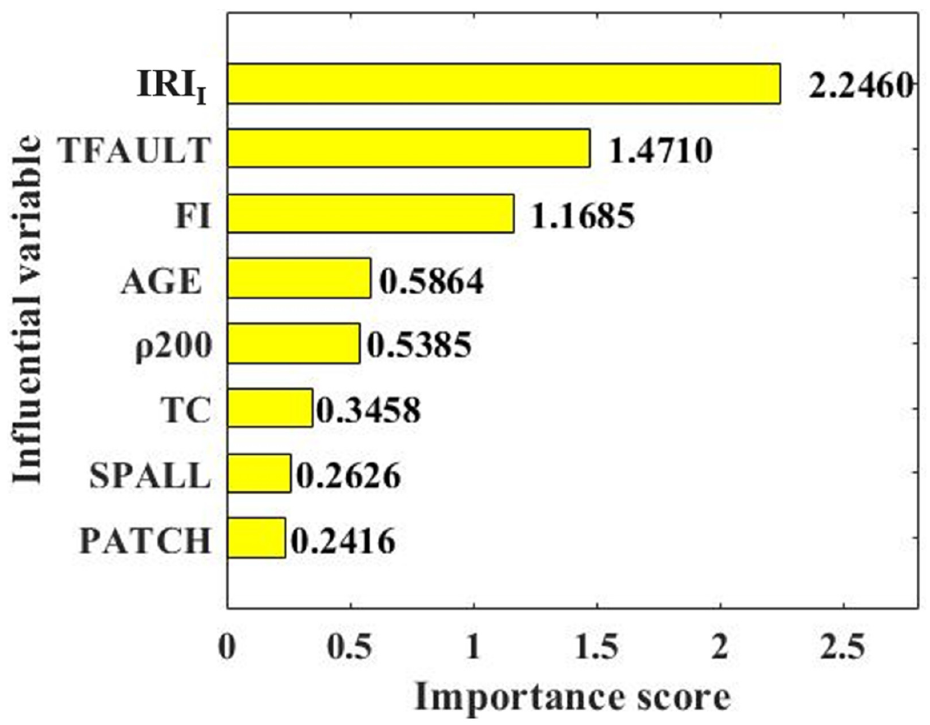
Figure 9. Importance score of the input variable.